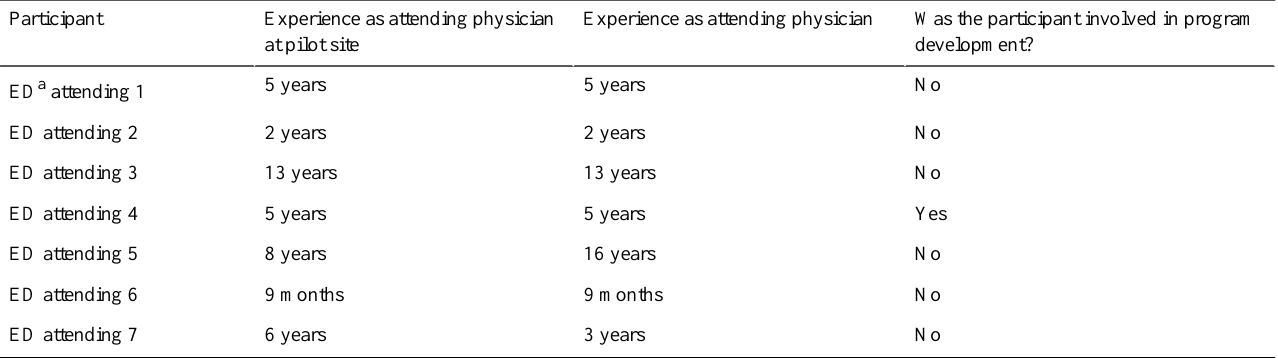
Table 2. Characteristics of emergency department attending